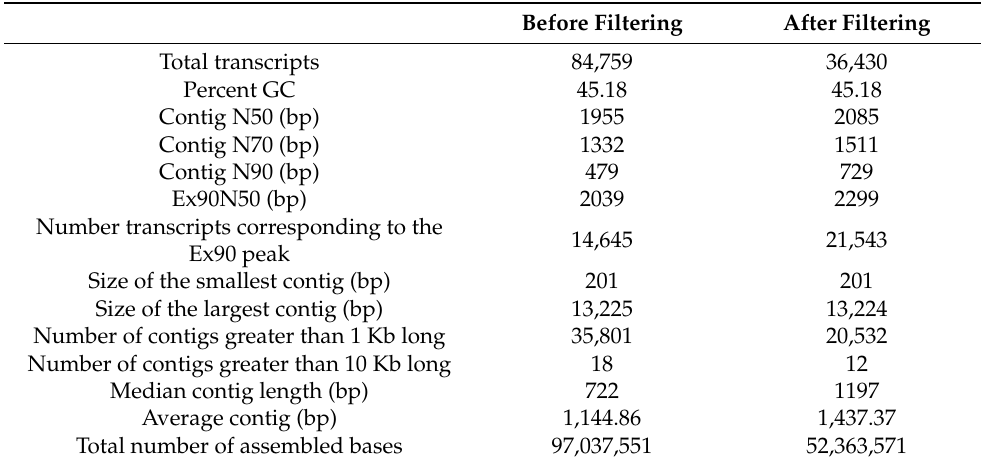
Table 2. Assembly statistics.